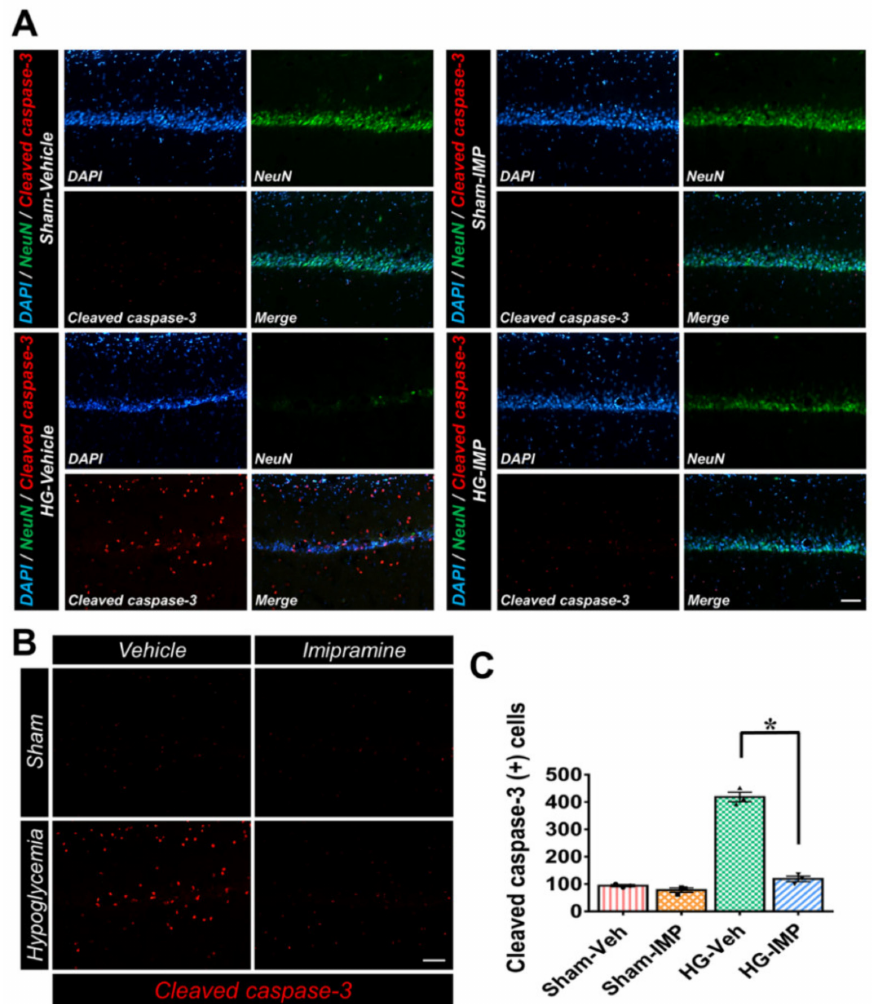
Figure 6. Administration of imipramine reduced the number of apoptotic cells after hypoglycemia: ( A ) cleaved caspase-3 (red) and NeuN (green) in the hippocampus CA1 region. After hypoglycemia, the administration of imipramine for 1 week decreased the number of apoptotic cells and increased the number of live neurons compared to the hypoglycemia-vehicle group. Scale bar = 100 µ m. ( B ) The bar graph indicates the quantification of the apoptotic cell number. Data are the mean ± SEM; n = 3 from each group. Individual data points ( • = Sham-Veh, (cid:4) = Sham-IMP, (cid:78) = HG-Veh, (cid:72) = HG-IMP). * Significantly different from the vehicle-treated group at p <